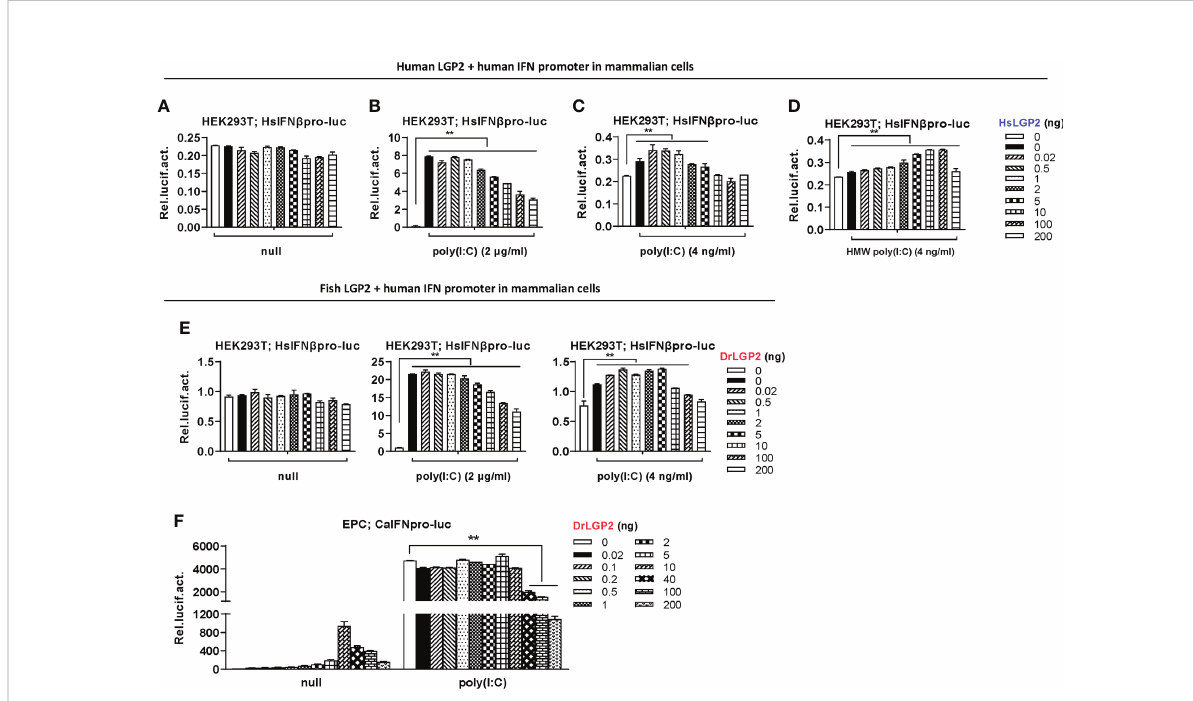
FIGURE 5 Zebra fi sh and human LGP2s play antithetic roles under low concentrations of poly(I:C) in mammalian cells and do so alone in fi sh cells. (A – E) Zebra fi sh and human LGP2s played antithetic roles under low concentrations of poly(I:C) in mammalian cells. HEK293T cells seeded in 24-wells plates were co-transfected with HsIFN b pro-luc (200ng), together with HsLGP2 (A – D) or DrLGP2 (E) (200 ng each). 24h later, cells were transfected again with MMW poly(I:C) [indicated as poly(I:C) in the text or all Figures] at 2 m g/ml (B, E) or at 4 ng/ml (C) , or with HMW poly(I:C) at 4 ng/ml (D) . Renilla vector (pRL-TK, 0.2 ng) was transfected as internal control. Another 24 h later, cells were collected for luciferase assays. P values were calculated using ANOVA. ** P < 0.01. (F) Overexpression of zebra fi sh or human LGP2s alone revealed antithetic roles in mammalian cells. EPC cells seeded in 24-well plates were transfected with DrLGP2 at the indicated increasing doses for 48 h. Or at 24 h post transfection, cells were transfected again with poly(I:C) at a high concentration of 1 m g/ml for another 24 h, followed by luciferase assays. P values were calculated using ANOVA. ** P <